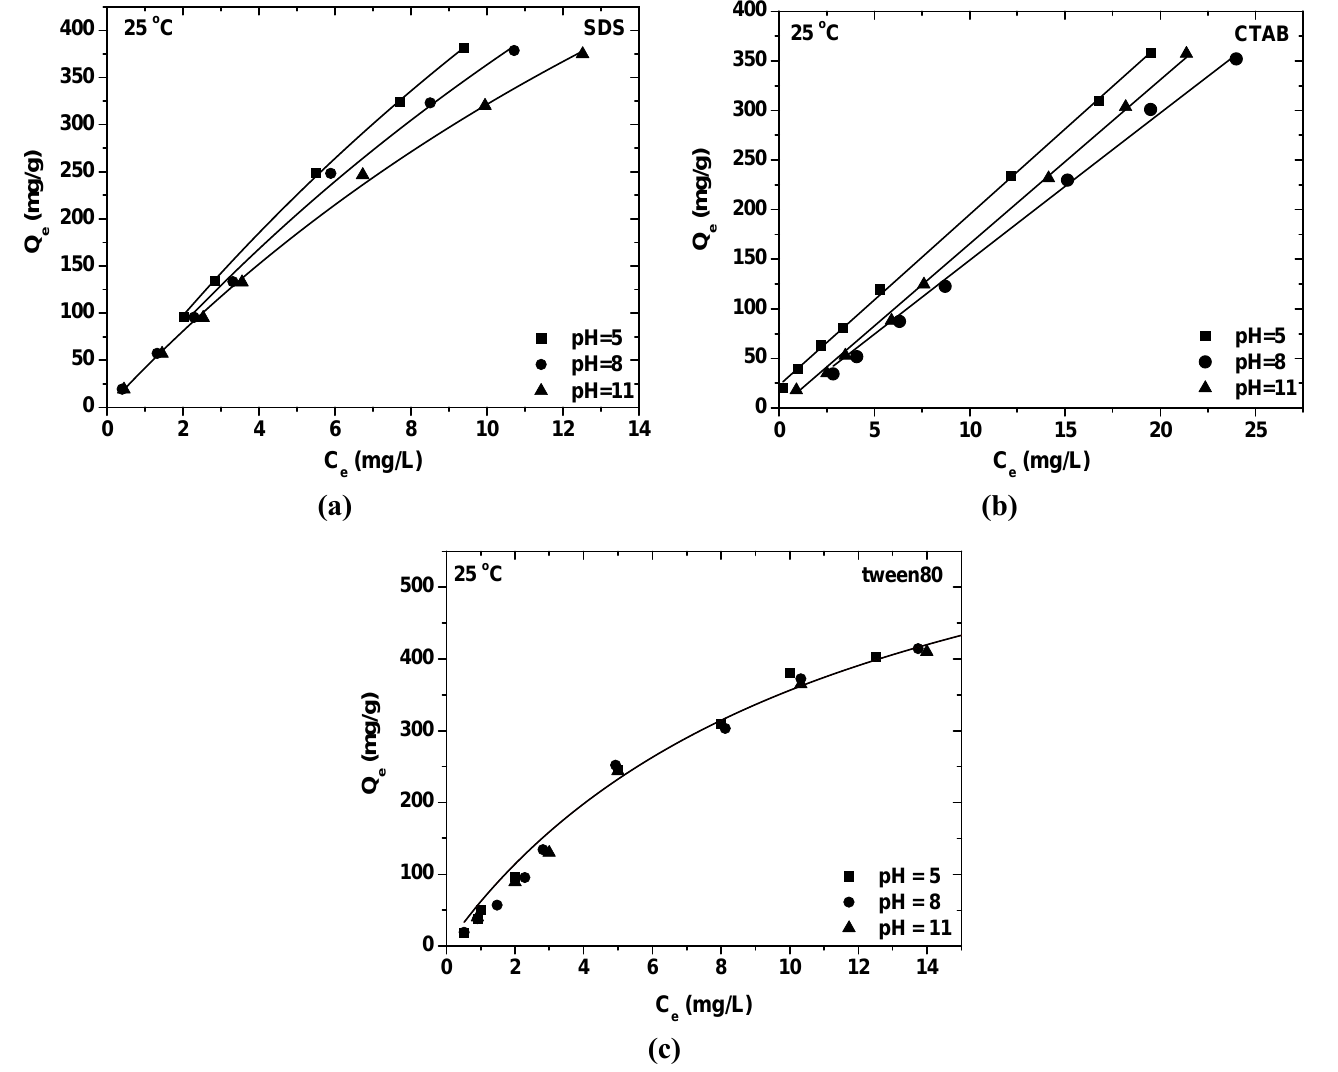
Figure 2. Effect of pH value on the adsorption of ( a ) SDS; ( b ) CTAB and ( c ) tween80